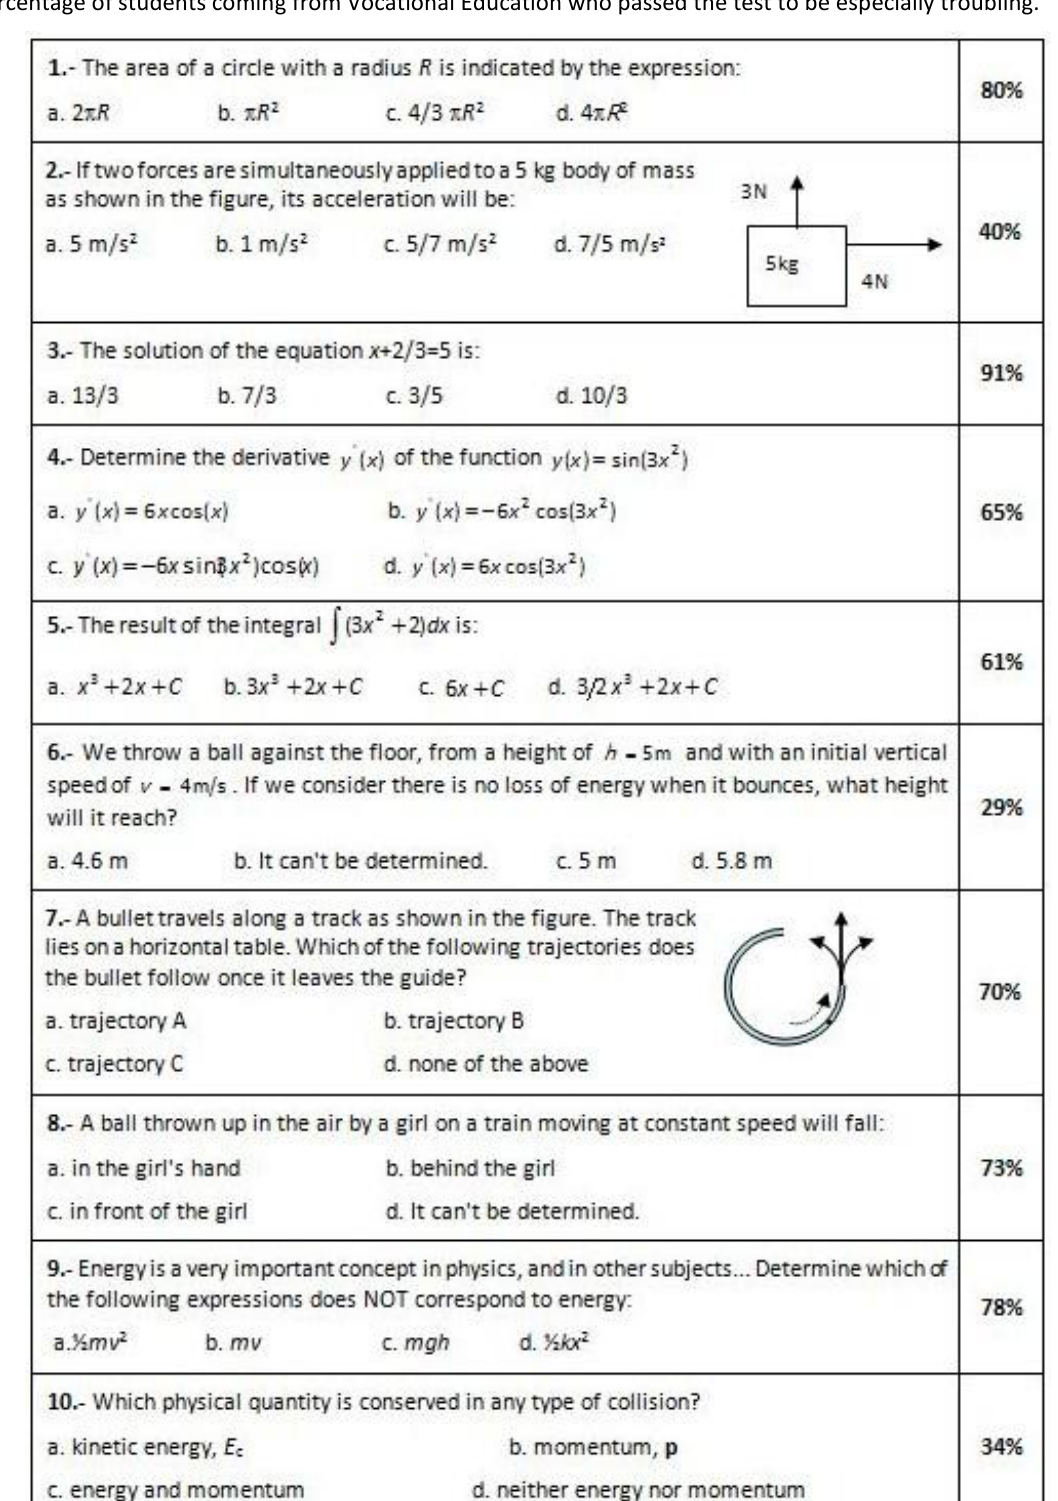
Table 1. Multiple choice knowledge test. The right column shows the success